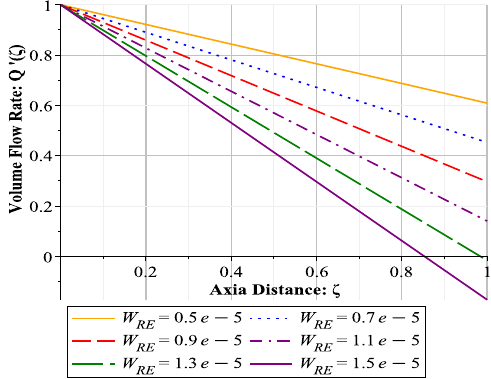
Figure 4. Behavior of Q’ ( ζ ) with ζ for different values of W RE .